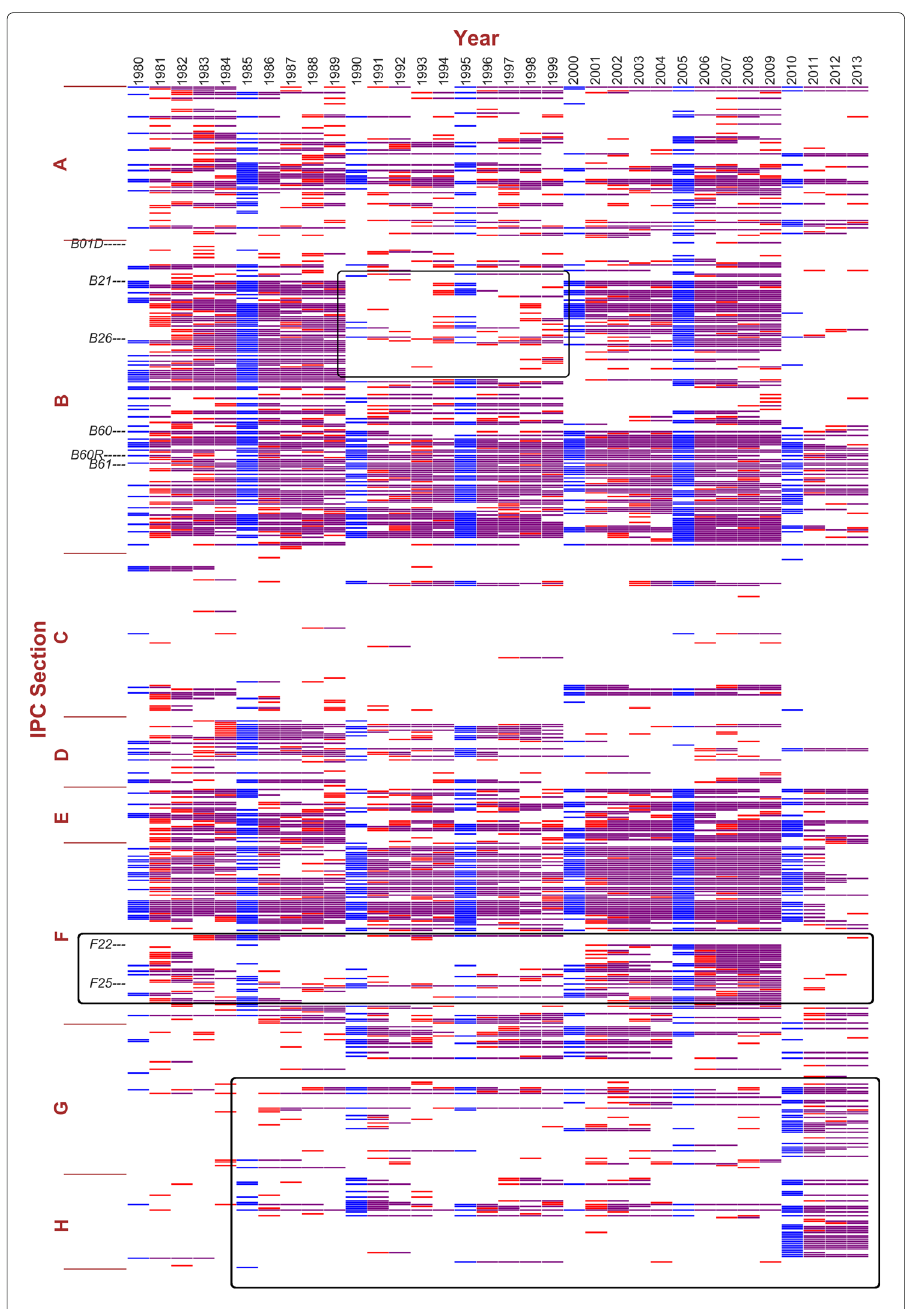
Fig. 6 Tracking community B60R in consecutive 5-year time windows, mapping to the previous year. The x-axis indicates years from 1980 to 2013, and the y-axis indicates the nodes, i.e. IPC subclasses, ordered in IPC index. The community mapping is based on consecutive 5-year windows. In each time window, the initial year’s community containing the central node set represented by B60R is shown in blue. In the rest 4 years, colored nodes represent the mapping communities: red indicates the node does not exist in the reference community (community of the previous year), and purple indicates the overlapping